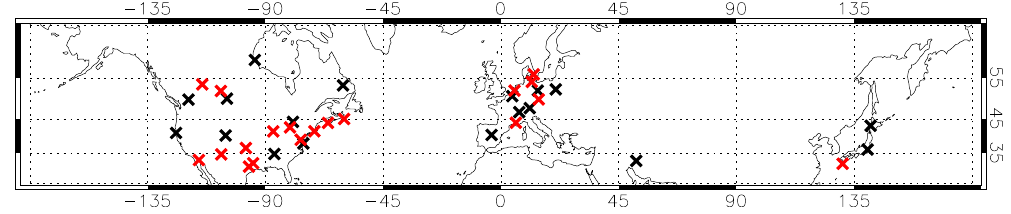
Fig. 1. Geographical distribution of the OS stations at mid-latitudes. Black and red stations are used for training and test,